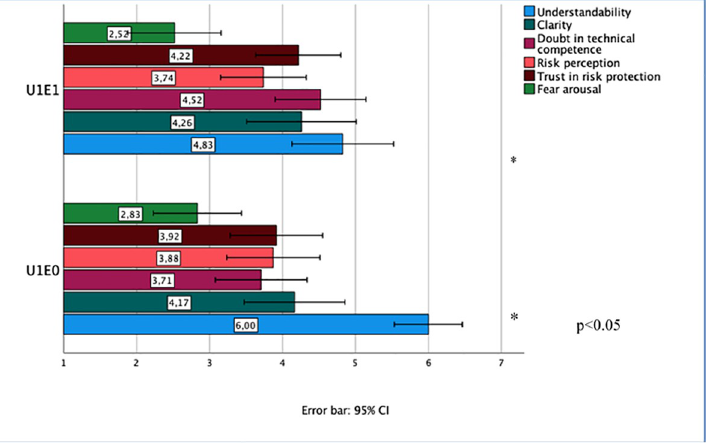
Fig 3. Effects of uncertainty explanation about protection by risk management (factor explanation) (R3). Means (with 95% confidence intervals) of the dependent variables (measured on 7-point Likert scales) for the two levels of factor “explanation”—U1E0: uncertainty, no explanation, U1E1: uncertainty, explanation, N.B.: The higher the score on the Likert scale the higher is the value on the dependent variable.